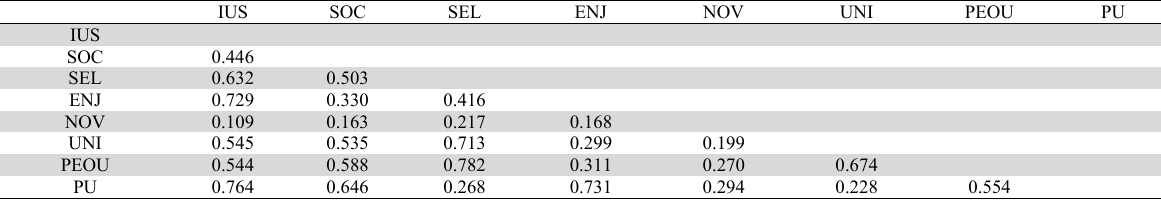
Heterotrait-Monotrait Ratio (HTMT)